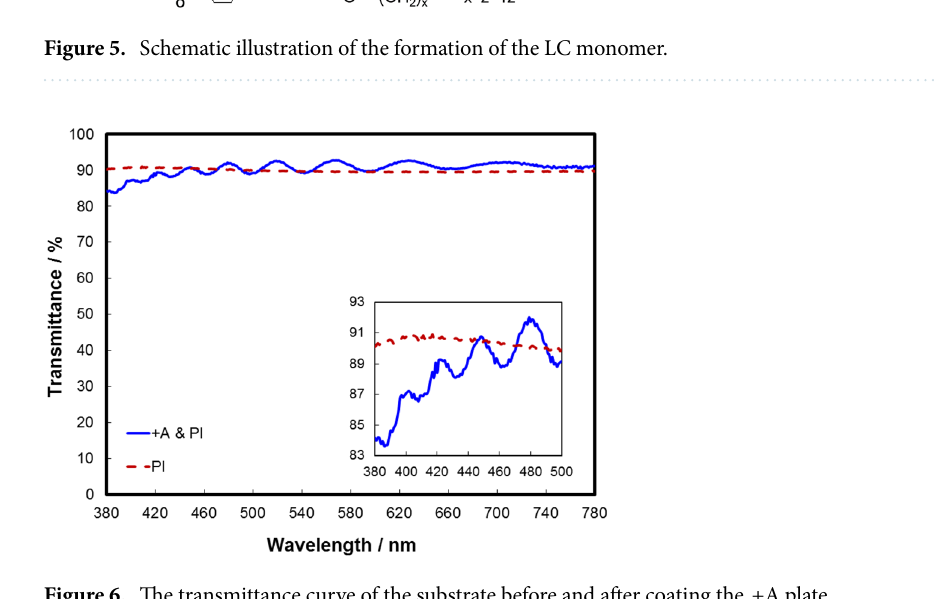
Figure 6. The transmittance curve of the substrate before and after coating the +A